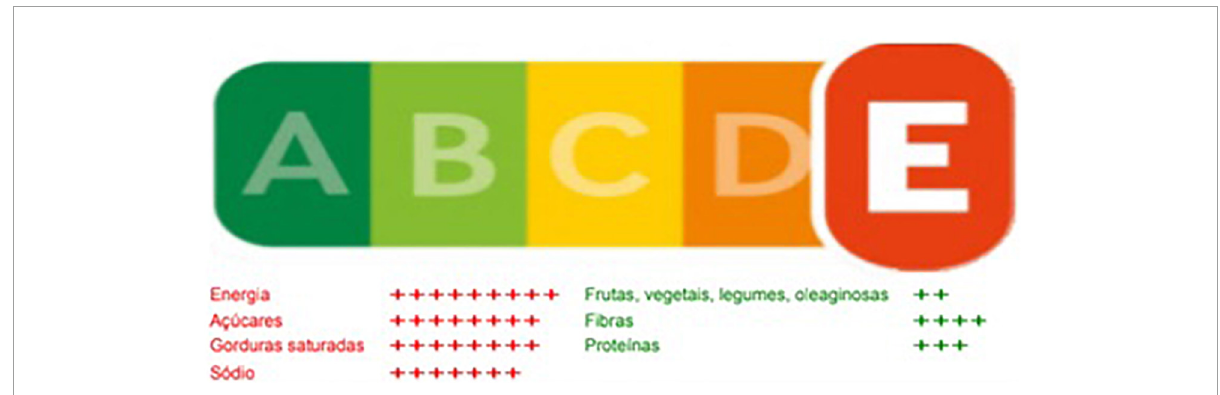
FIGURE3 Front-of-package nutrition labeling (FoPNL) model proposed by ABRAN. Source: